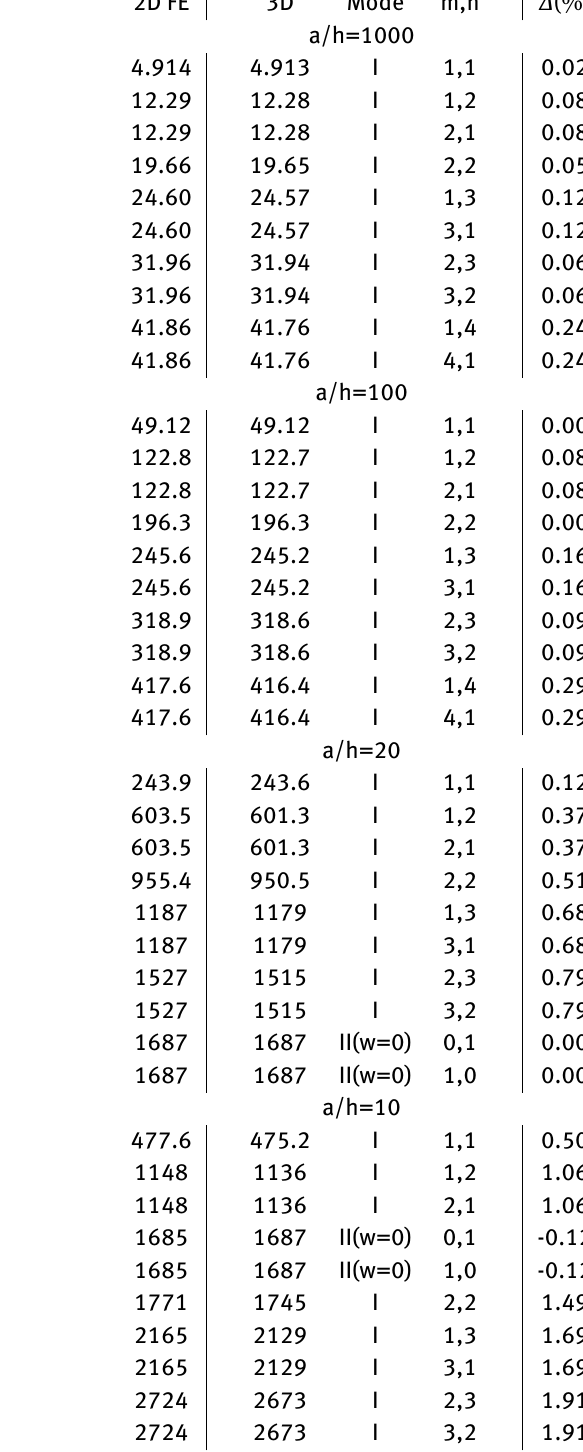
Table 11: Fourth benchmark, simply supported cylinder made of alu- minium alloy and titanium alloy with thickness ratios R α /h=1000, comparison between the present 3D exact solution and the 2D FE